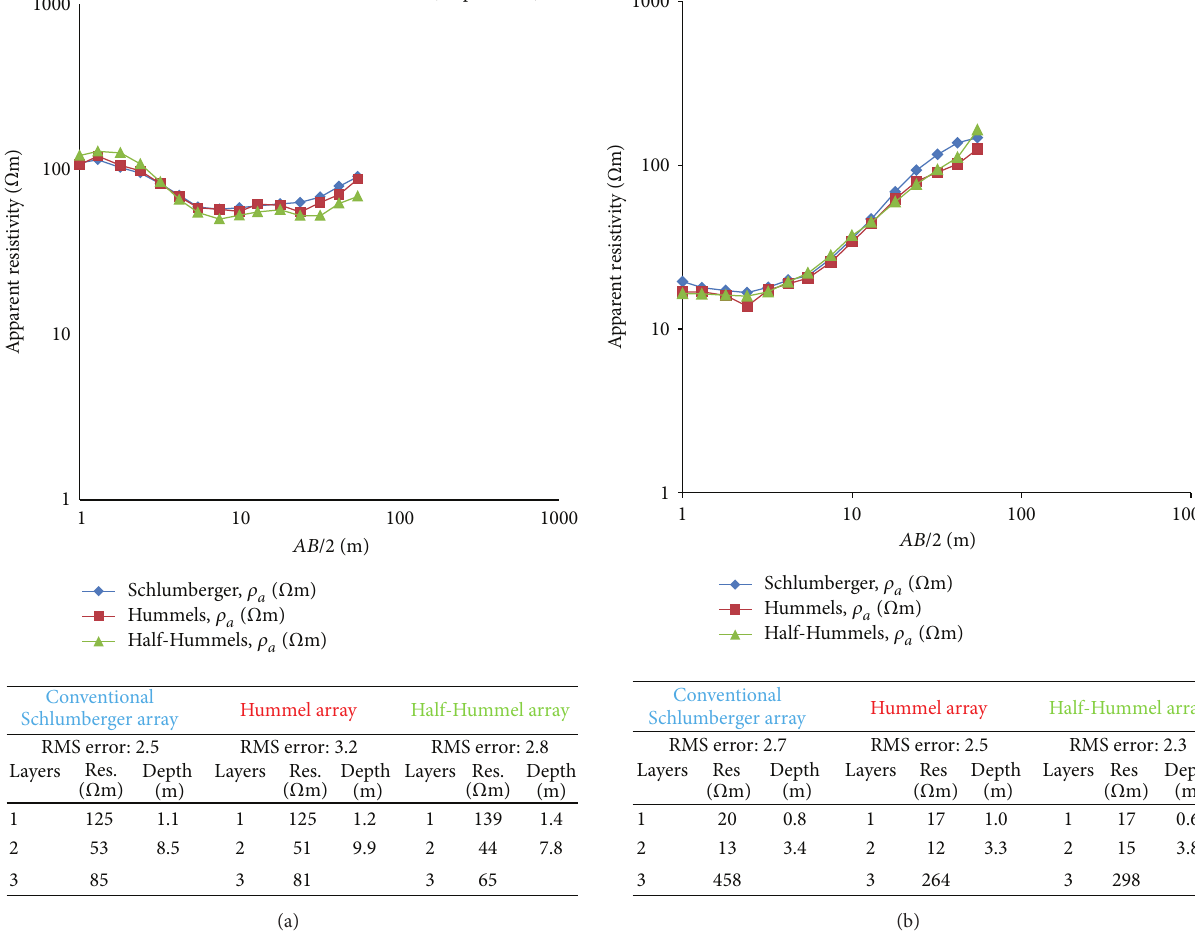
Figure 23: Comparison of results obtained from the interpretation of field data collected using the different array methods at VES stations on amphibolite for (a) location 16, Oki Ibadan, and (b) location 19, Oki